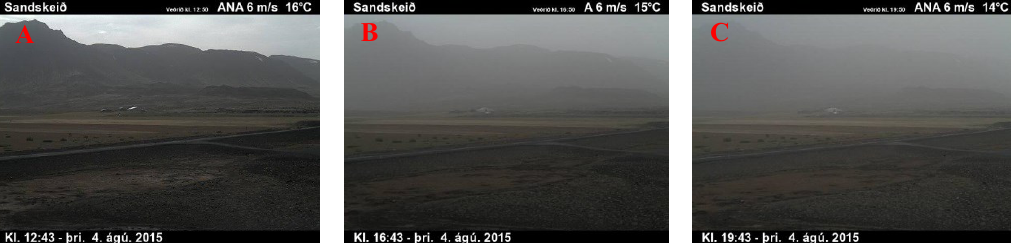
Figure 4. Changes in visibility during Storm 2 on 4 August 2015 when dust was blowing from Hagavatn. Left photo ( A ) shows visibility >3.5 km, corresponding to PM 10 of 71 µg·m −3 , measured by a DustTrak instrument at the site. The middle photo ( B ) shows visibility of about 3.5 km corresponding to an estimated PM 10 of 370 µg·m −3 , while the photo on the right ( C ) shows about 1 km visibility, corresponding to an estimated PM 10 of >780 µg·m −3 based on the formula from Dagsson- Waldhauserova et al. [23]. The images are from a web camera from the Icelandic Road and Coastal Administration.